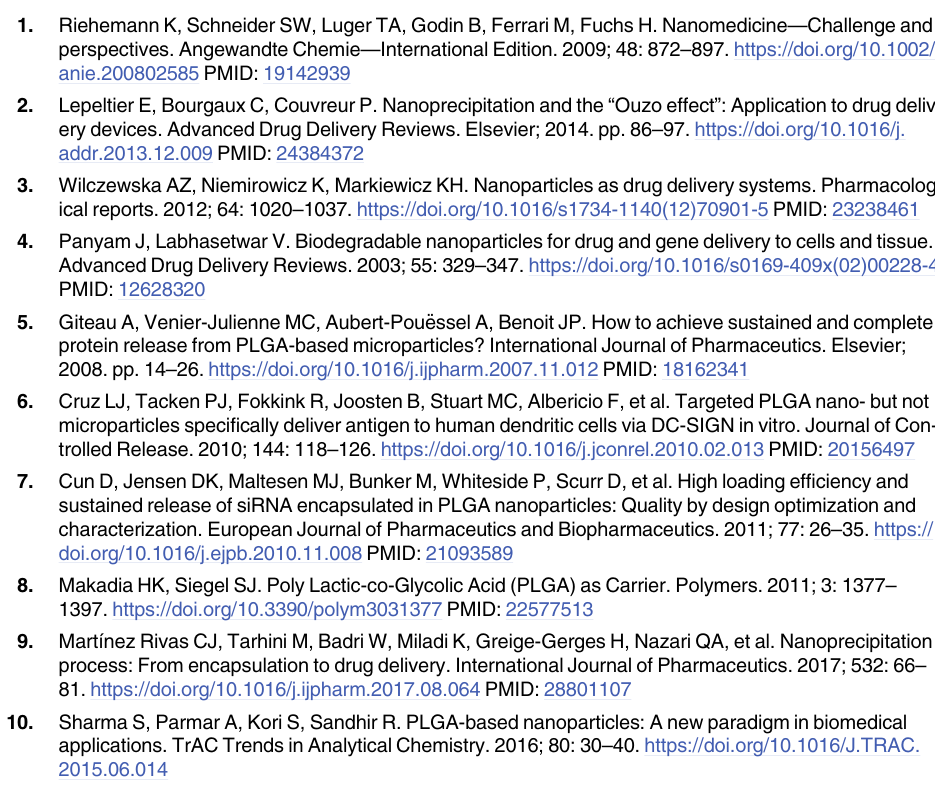
S1 Table. Formulation